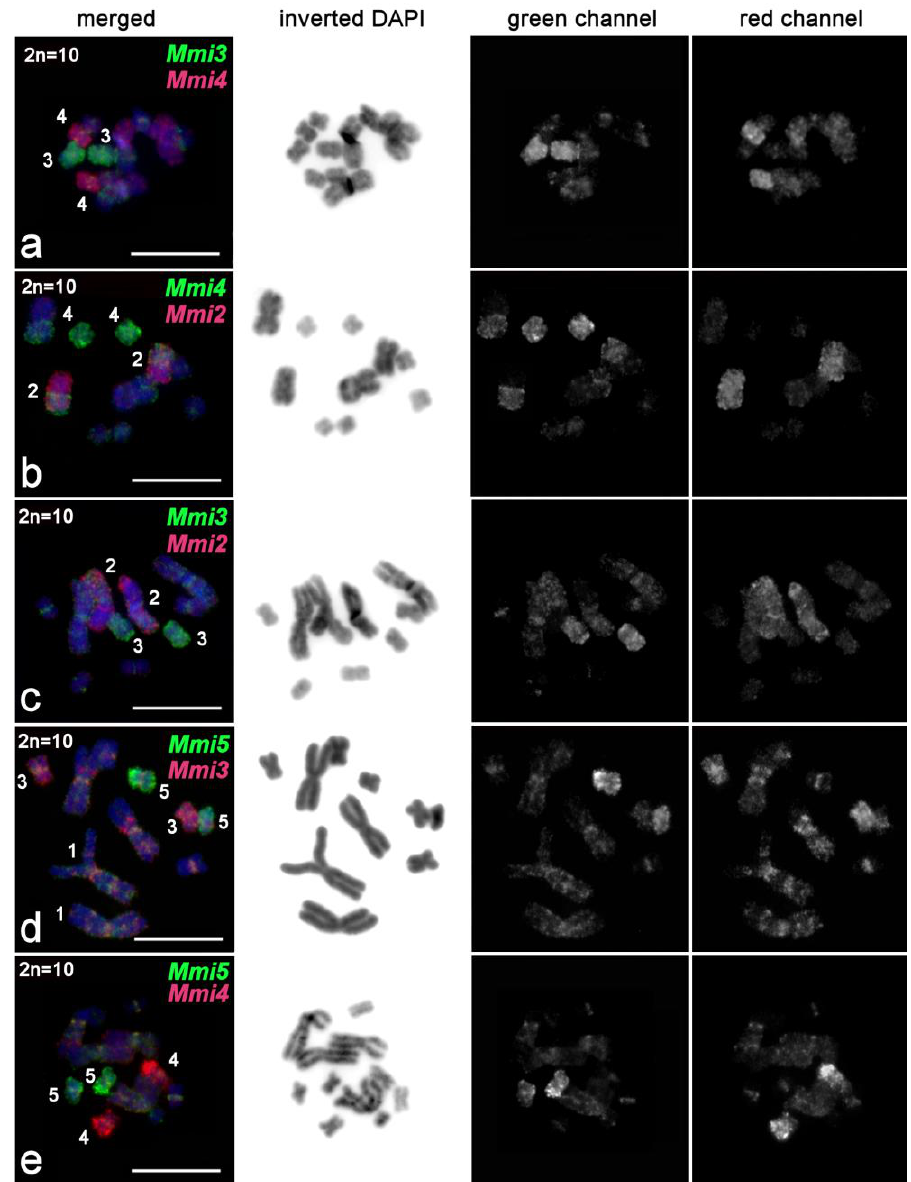
Figure 9. Chromosome painting with single-copy DNA probes on chromosomes of M. mirumnovem . FISH with ( a ) Mmi3 (green) and Mmi4 (red) probes; ( b ) Mmi4 (green) and Mmi2 (red) probes; ( c ) Mmi3 (green) and Mmi2 (red) probes; ( d ) Mmi3 (red) and Mmi5 (green) probes; ( e ) Mmi4 (red) and Mmi5 (green) probes. Chromosomes were counterstained with DAPI (blue).